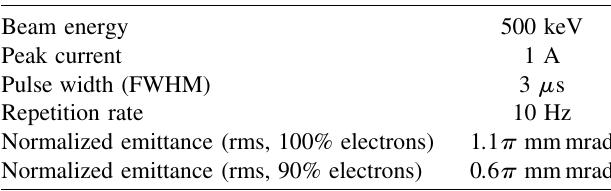
TABLE II. Demonstrated beam parameters at gun exit. Beam